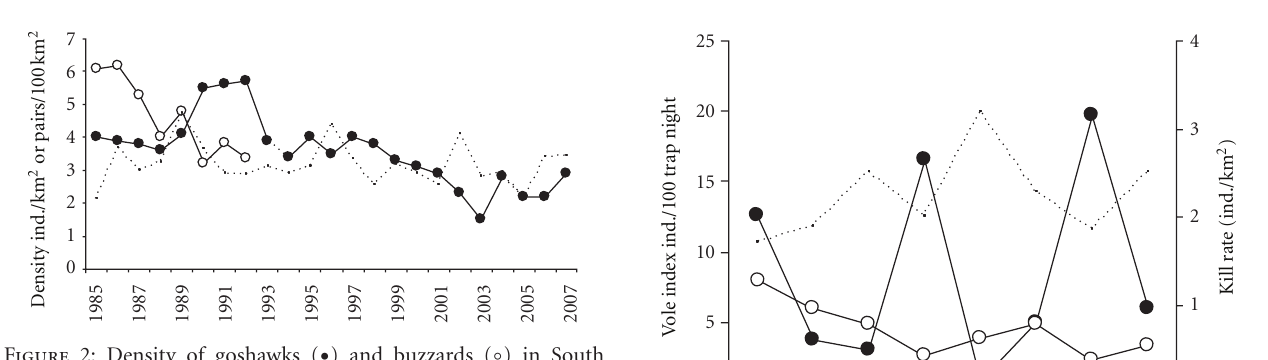
Figure 2: Density of goshawks ( • ) and buzzards ( ◦ ) in South Ostrobothnia during 1985–1993 and goshawks in Oulu area during 1994–2007. Density of the female black grouse is presented for both study areas (dashed line). Time series of the two study areas are separated by dotted line. Figure 3: Vole index ( • ), kill rate of black grouse chicks by buzzards ( ◦ ) and combined kill rate by buzzards and goshawks (dashed line) in South Ostrobotnia in western Finland during